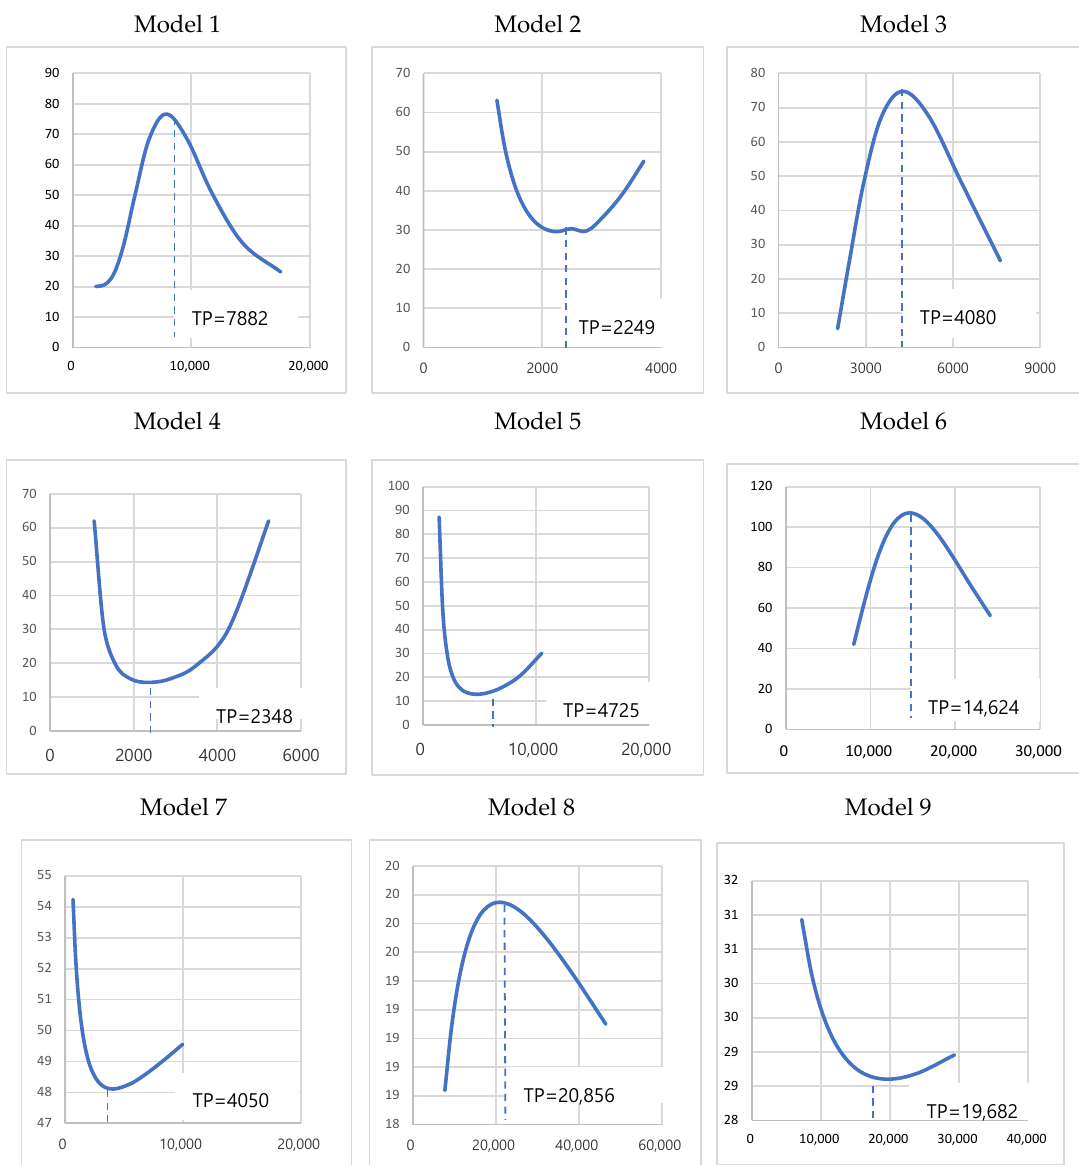
Figure A2. Pollution-Growth Patterns. Notes: The X-axis is GRP per capita ($), Y-axis is per capita SO 2 emission (ton).TP means the level of GRP per capita at the turning points of each